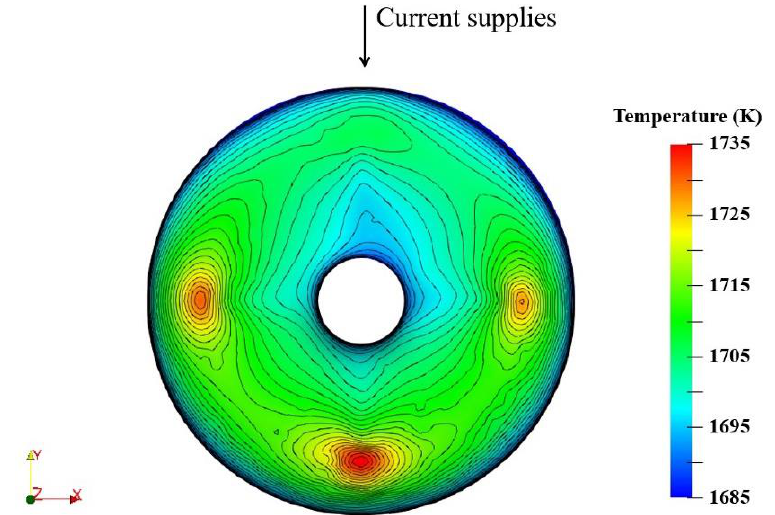
Figure 5. Temperature distribution at the free surface of melt. Below the three side slits, the temperature is high because of high power density.